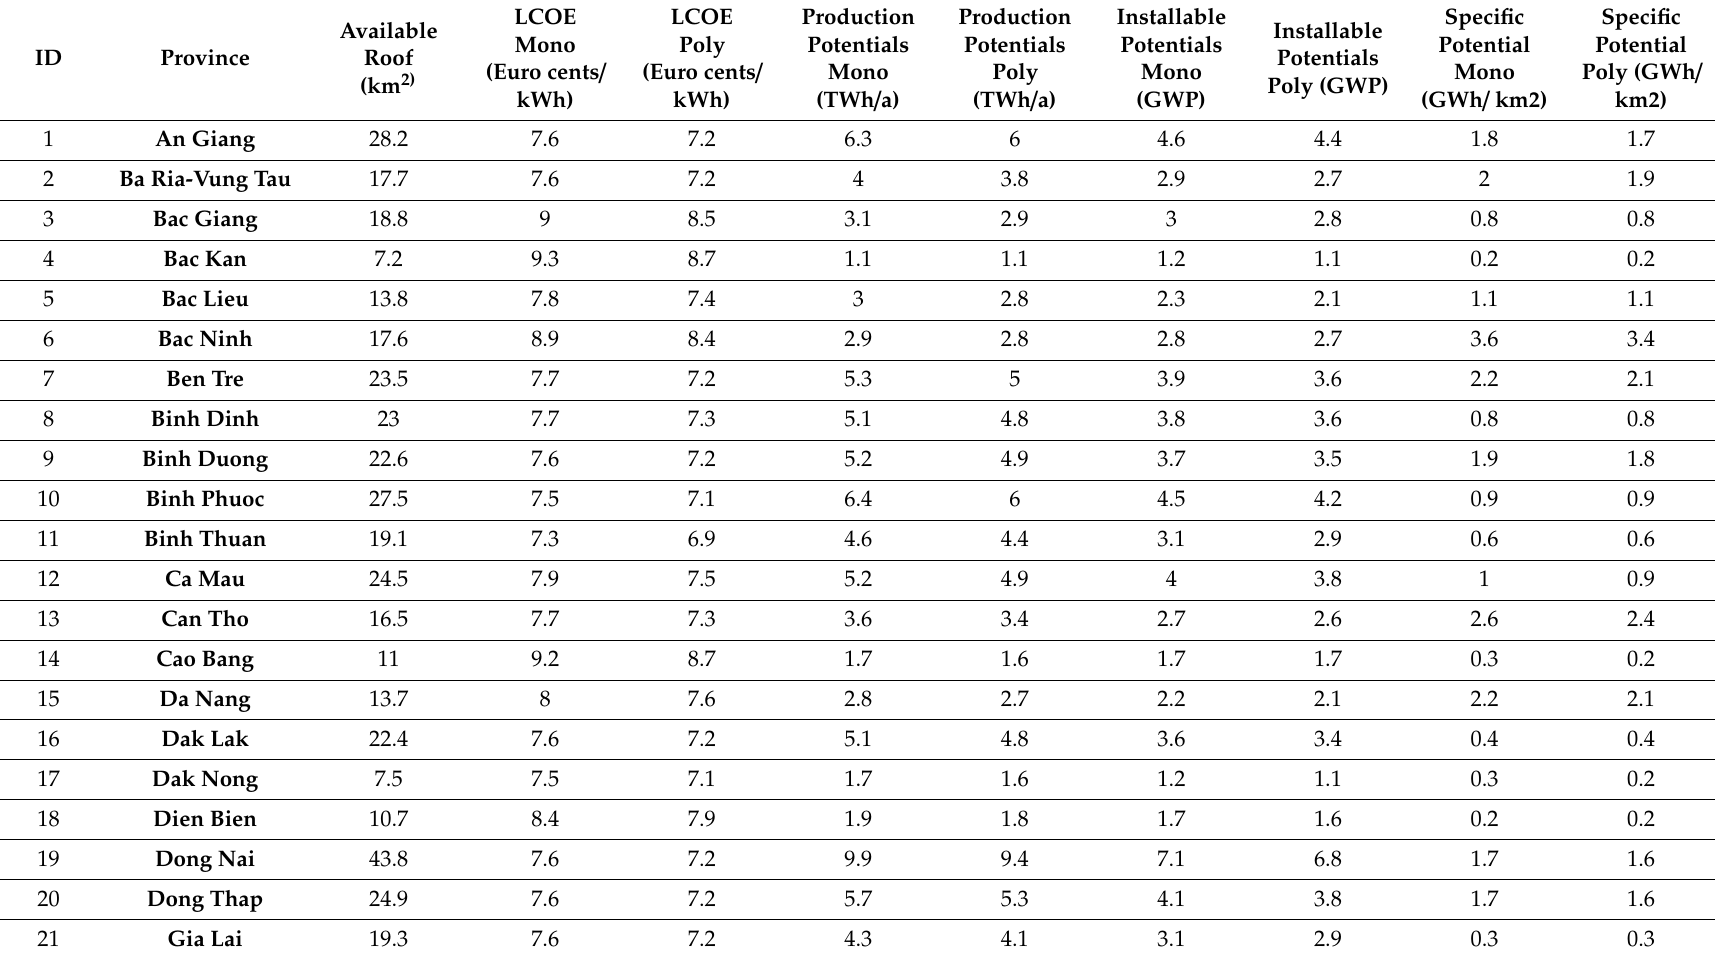
Table A3. Results of potential